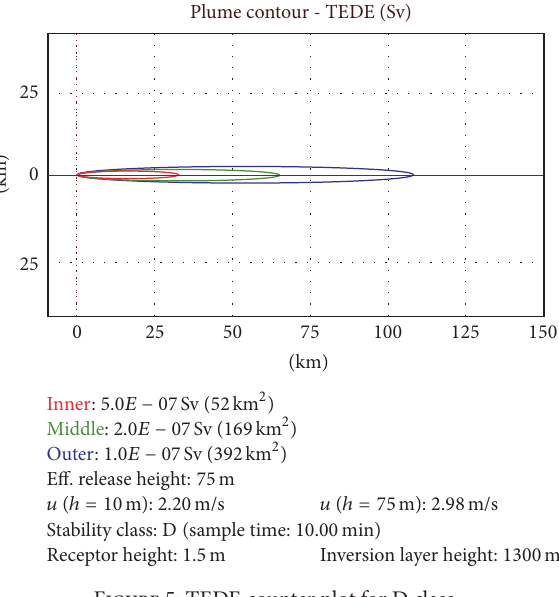
Figure 5: TEDE counter plot for D class.